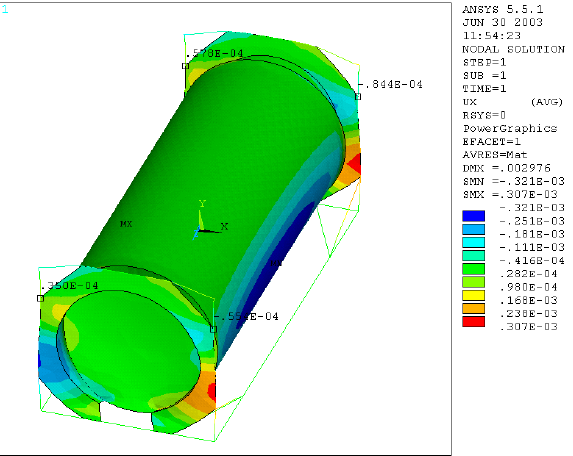
Figure 7. Displacements along x.